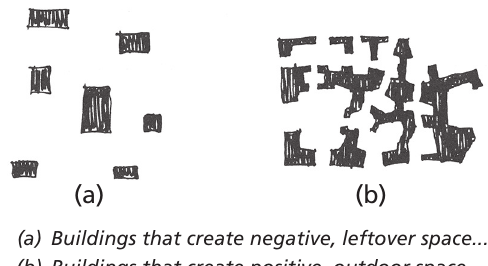
Figure 6. Illustration of Pattern #106. Positive Outdoor Shape. Source: { A Pattern Language } [13].